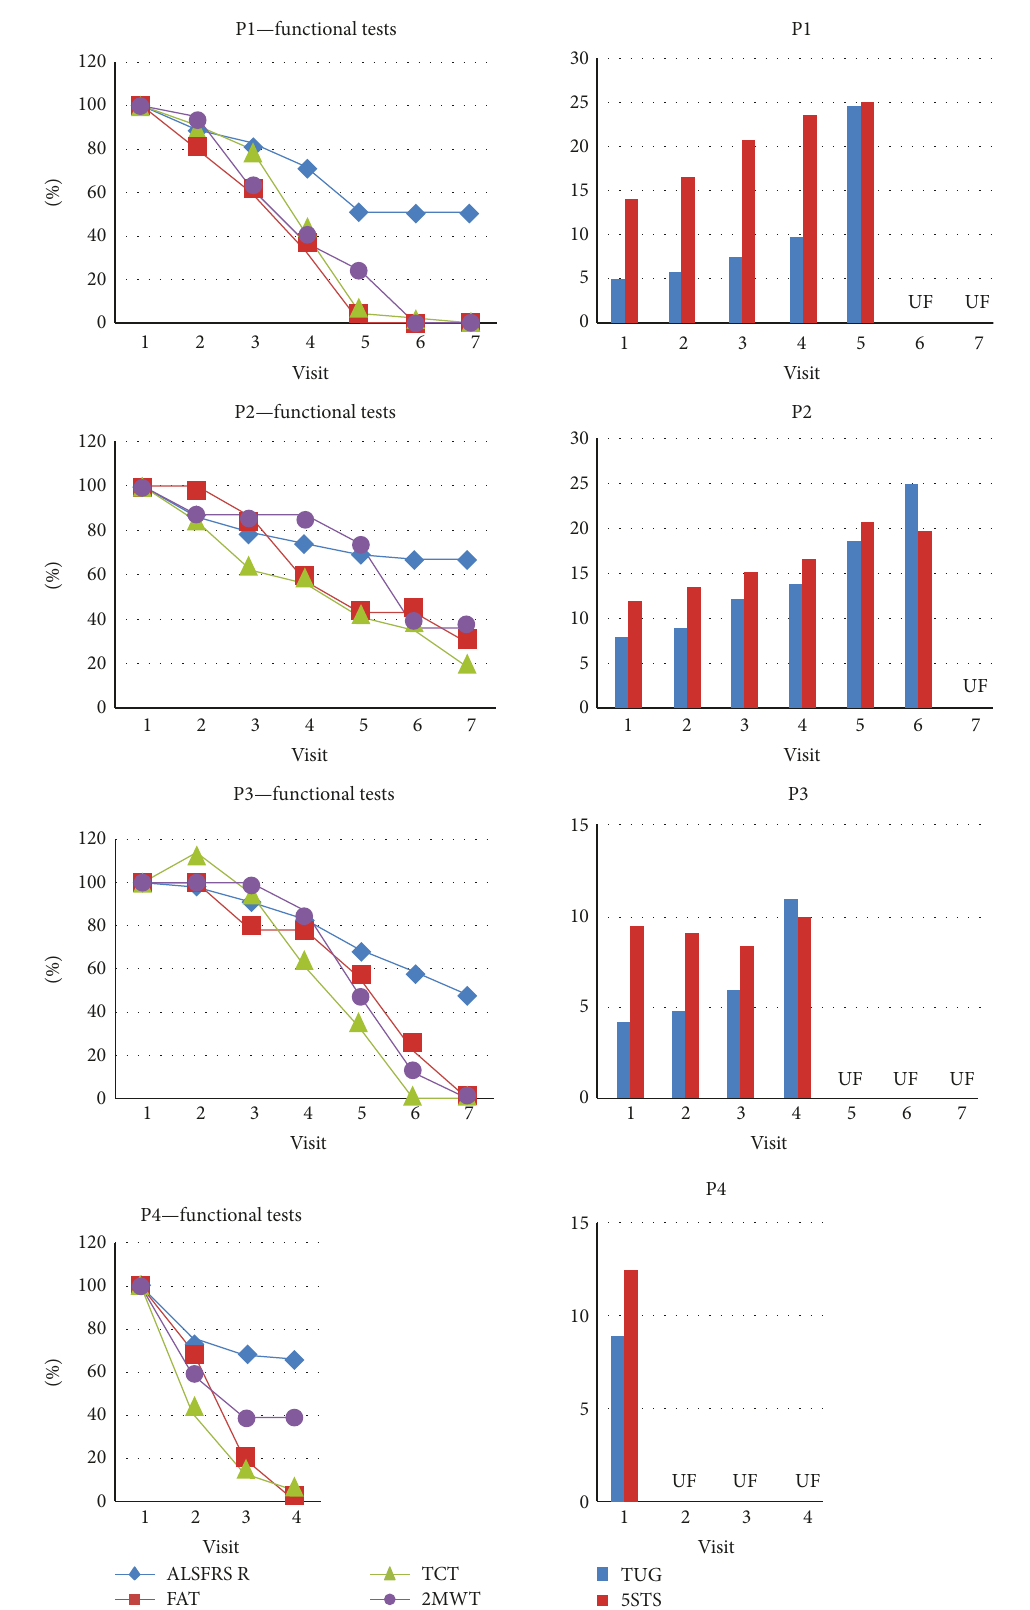
Figure 6: Comparison of the course of the disease before and after the cell therapy. The graphs show the course of disease preceding the use of ADRC (blue graph) and the course of disease during cell